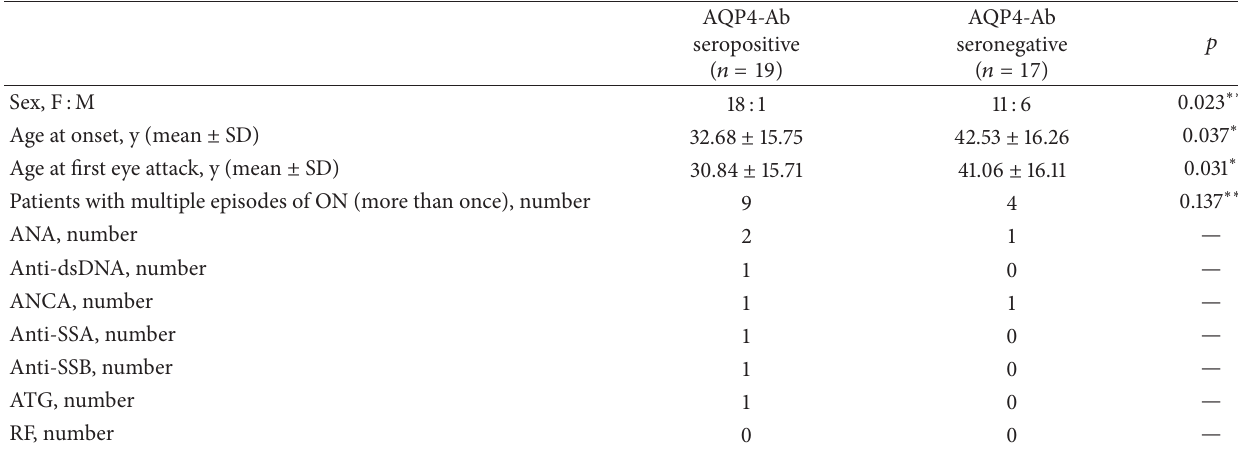
Table 1: Characteristics of patients with